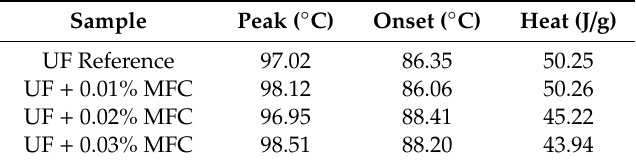
Table 16. DSC analysis results, Experiment 3.1.4 (Approach